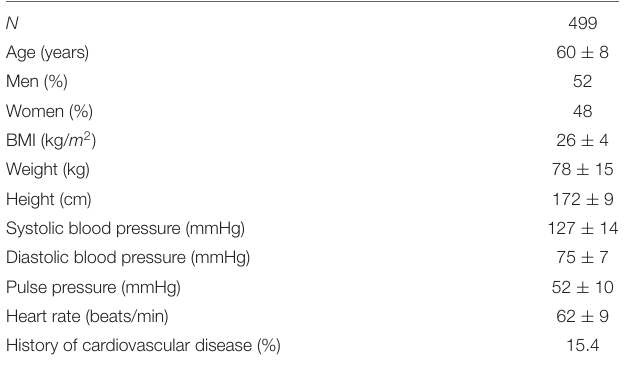
FIGURE 1 | Fast B-mode ultrasound recording of the common carotid artery with the 17 M-lines indicated. The middle M-line (no. 9) was selected as a proxy for a single M-line device and is indicated by dashed (yellow)